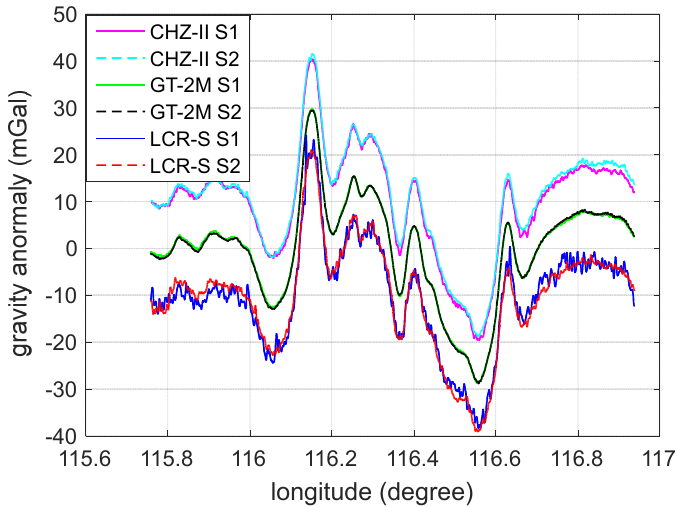
Figure 3. The gravity anomaly measurement results of the three sets of instruments on the S1 and S2 survey lines after matching them by position.